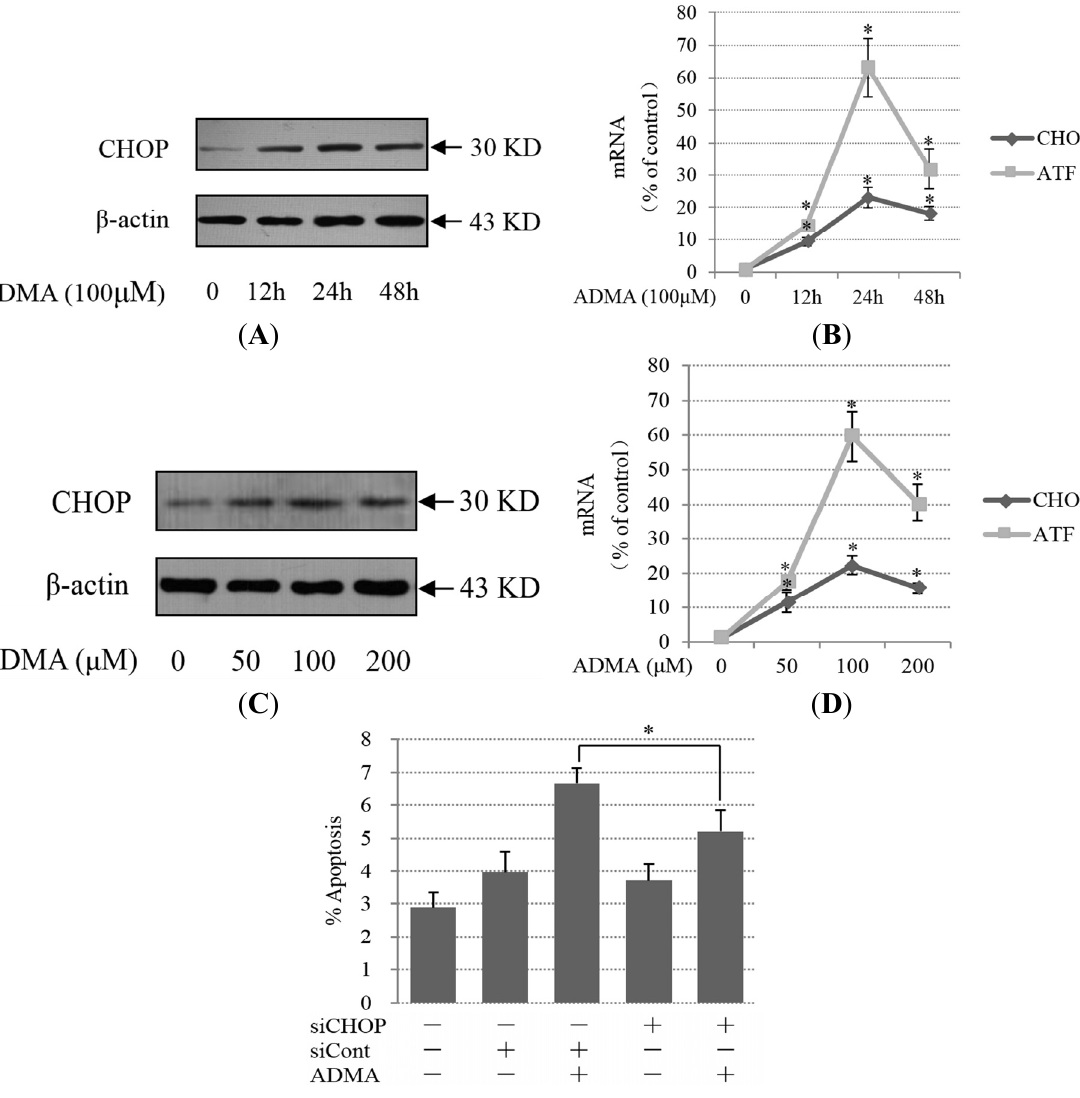
Figure 2. Role of PERK-CHOP ER stress pathway in ADMA-induced GEnC